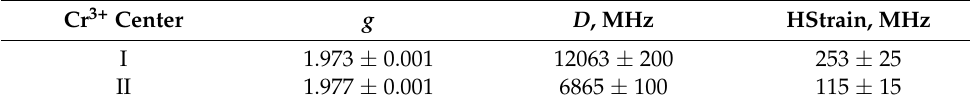
Table 2. Fitted SH parameter values of Cr 3+ centers in